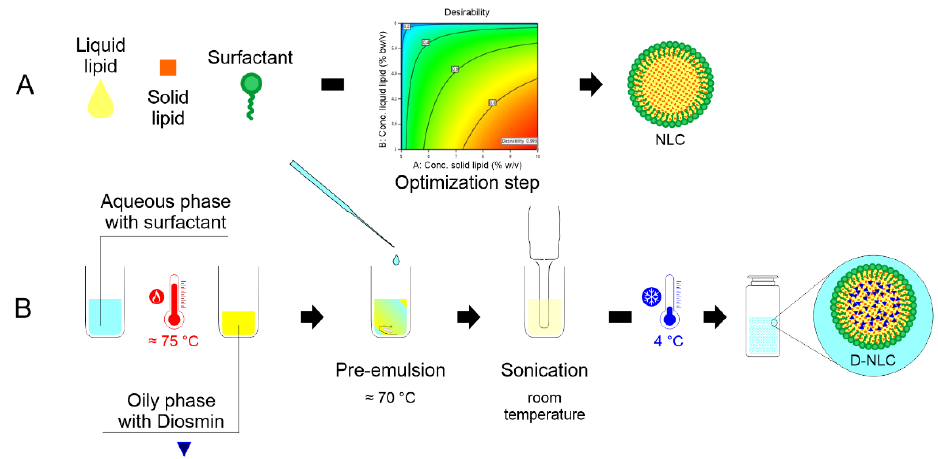
Figure 1. Scheme of production of blank NLCs ( A ) and diosmin-loaded nanoparticles (D-NLCs, ( B )).